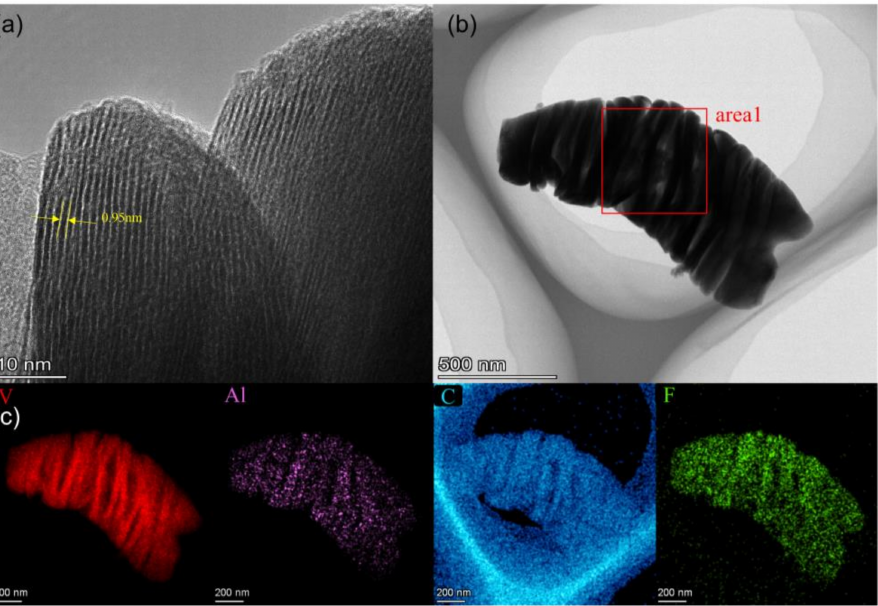
Figure 3. ( a ) SEM image of V 2 AlC, ( b – f ) SEM images of V 2 C-24, V 2 C-48, V 2 C-72, V 2 C-96, and V 2 C-120, respectively. ( g ) SEM image of V 2 C-50 ◦ C, ( h ) SEM image of V 2 C-70 ◦ C, ( i ) SEM image of Na 5 Al 3 F 14 .